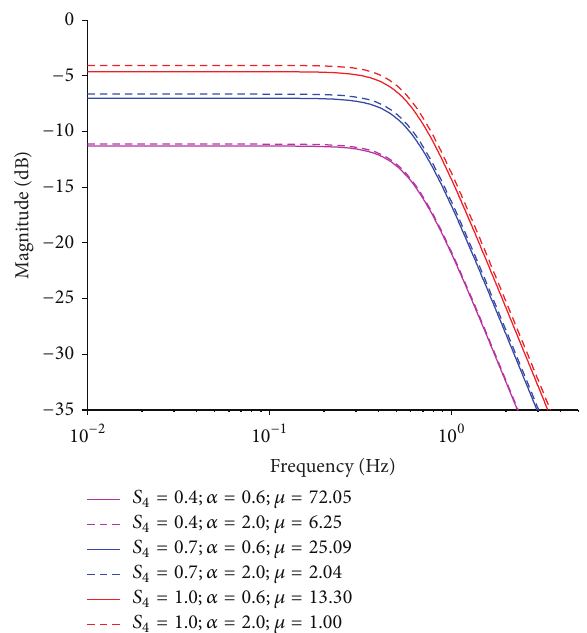
Figure 4: Nakagami- 𝑚 (dashed) and 𝛼 - 𝜇 (solid) PSDs for 𝑆 4 = 0.4 , 0.7, and 1.0. The 𝛼 - 𝜇 examples assume the approximation 𝛼 = ) and determine 𝜇 from 1/ log (10𝑆 4